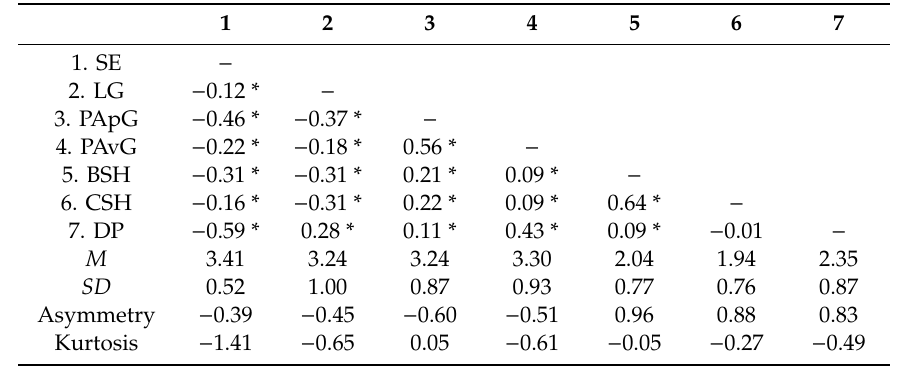
Table 1. Descriptions and correlations between self-esteem, achievement goals, and self-protection strategies ( N = 1028).